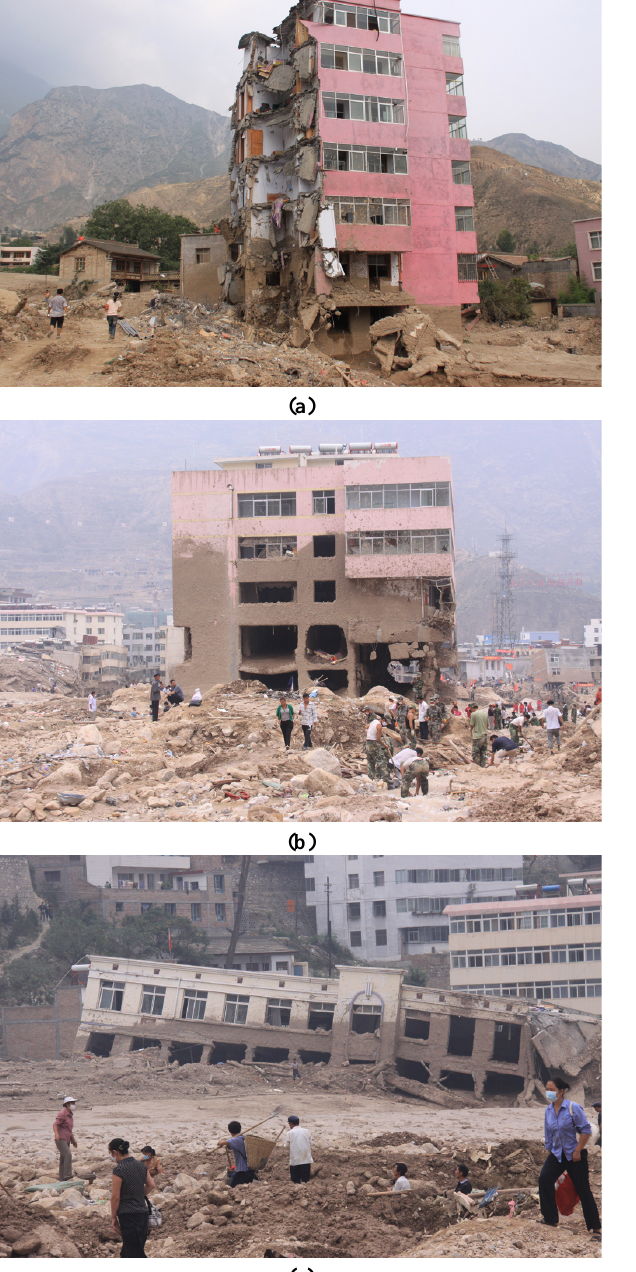
Fig. 4. Comparison of damage to buildings by frontal impact with damage by lateral abrasion and accumulation. (a) Sidewall of build- ing B. (b) Buildings F and G. (c) Relative position of buildings F and G on an aerial